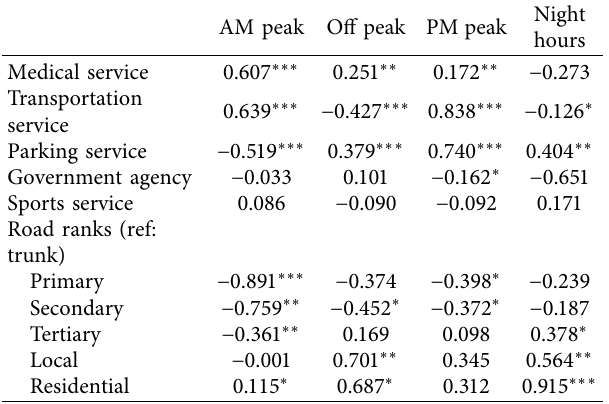
Table 8: Impact of public service POIs on road